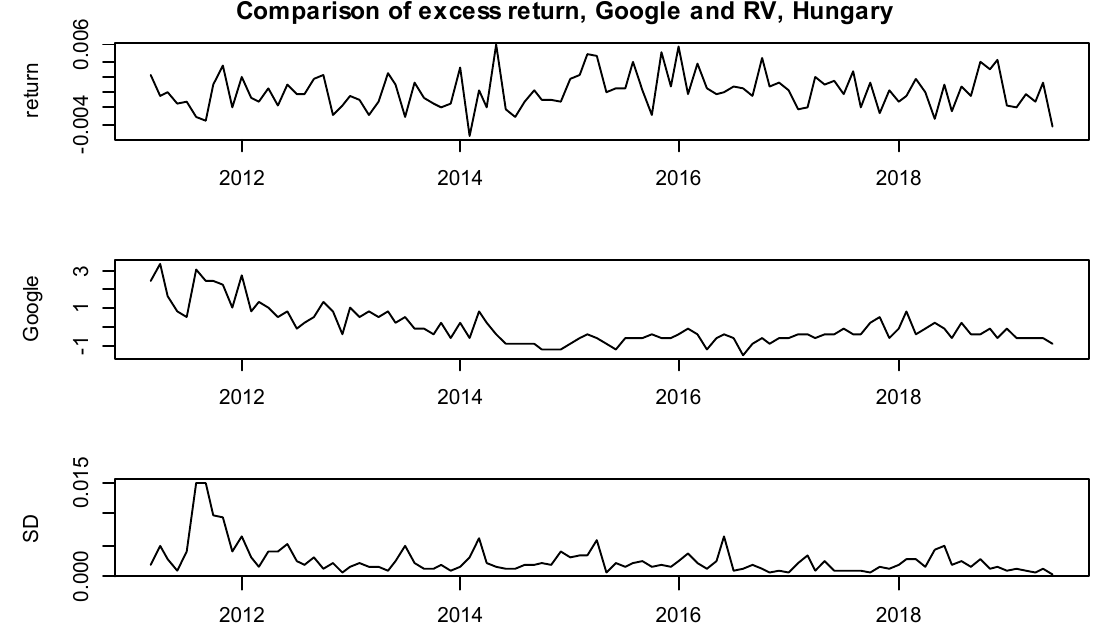
Figure A2. Comparison of monthly series: Excess return, RV and Google search volume, Hungary.